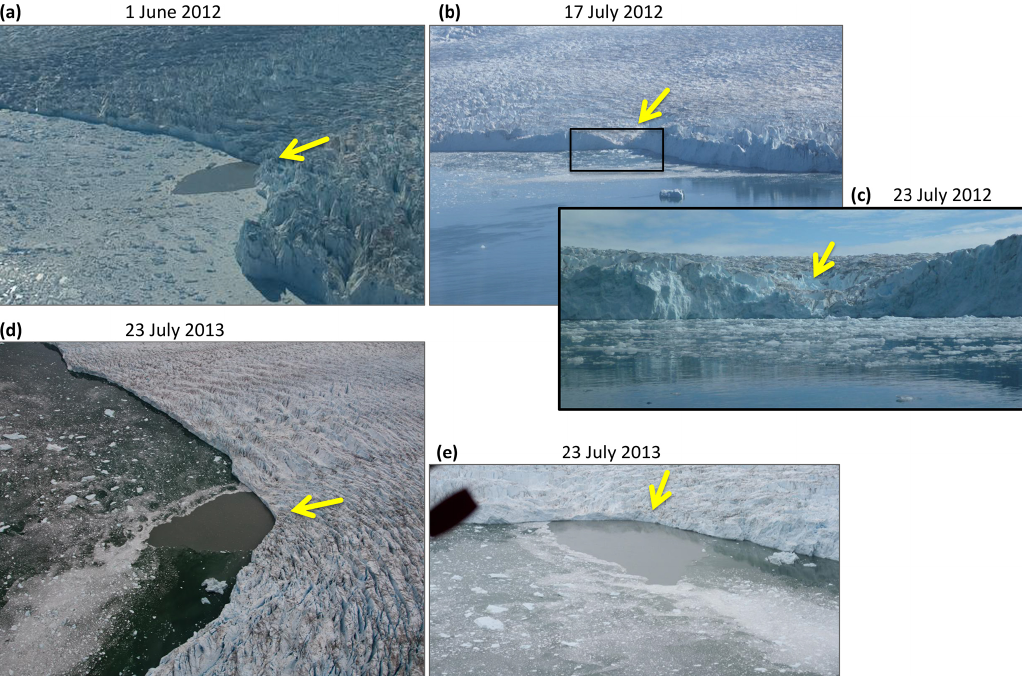
Figure 4. Aerial images of the main plume at Saqqarliup–Saqqarleq front visible at the fjord surface on (a) 1 June 2012, (d) and (e) 23 July 2013 but absent on (b) 17 July 2012. Also absent was the plume on 23 July 2012, as shown in (c) , a photograph taken from the boat, which covers the black rectangle in (b) . The yellow arrows approximately indicate the ice flow direction in that corner of the glacier and point at the plume origin. The brown plume surface expression in (d) extends approximately 200m along the glacier front and around 300m into the fjord.